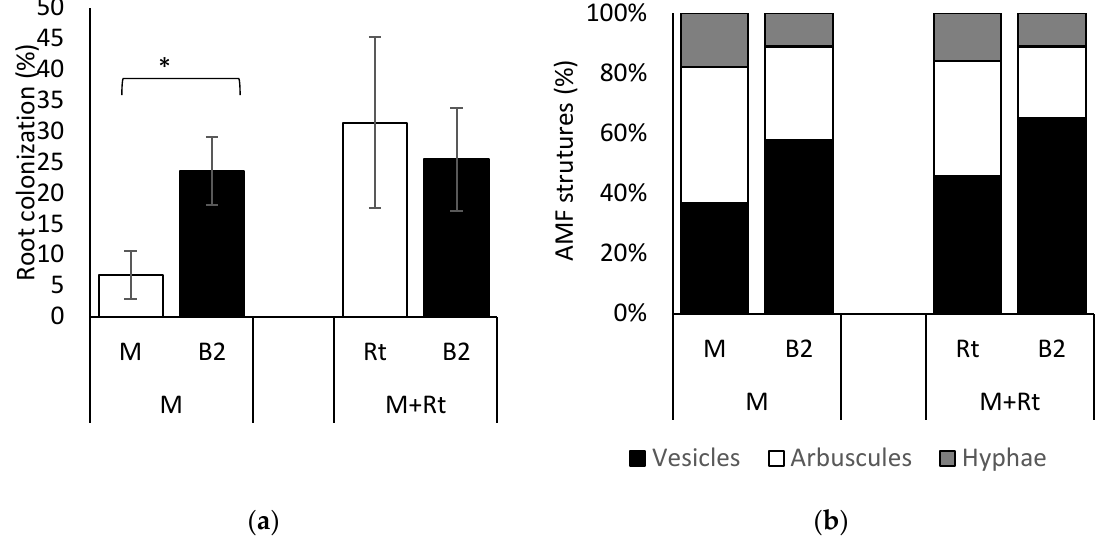
Figure 3. Effect of coinoculation of Rhizobium tropici and riboflavin (vitamin B2) in Phaseolus vulgaris . ( a ) Percentage of root colonization by Arbuscular mycorrhizal fungi (AMF) colonization percentage, and ( b ) percentage of colonization by AMF structures in roots with or without riboflavin and with or without Rhizobium tropici 35 days after inoculation. N = 4. Bars represent the mean ± standard deviation. M, AMF inoculum; B2, riboflavin (50 µM); Rt, R. tropici CIAT 899. *, significant differences ( t -test, p ≤ 0.05).